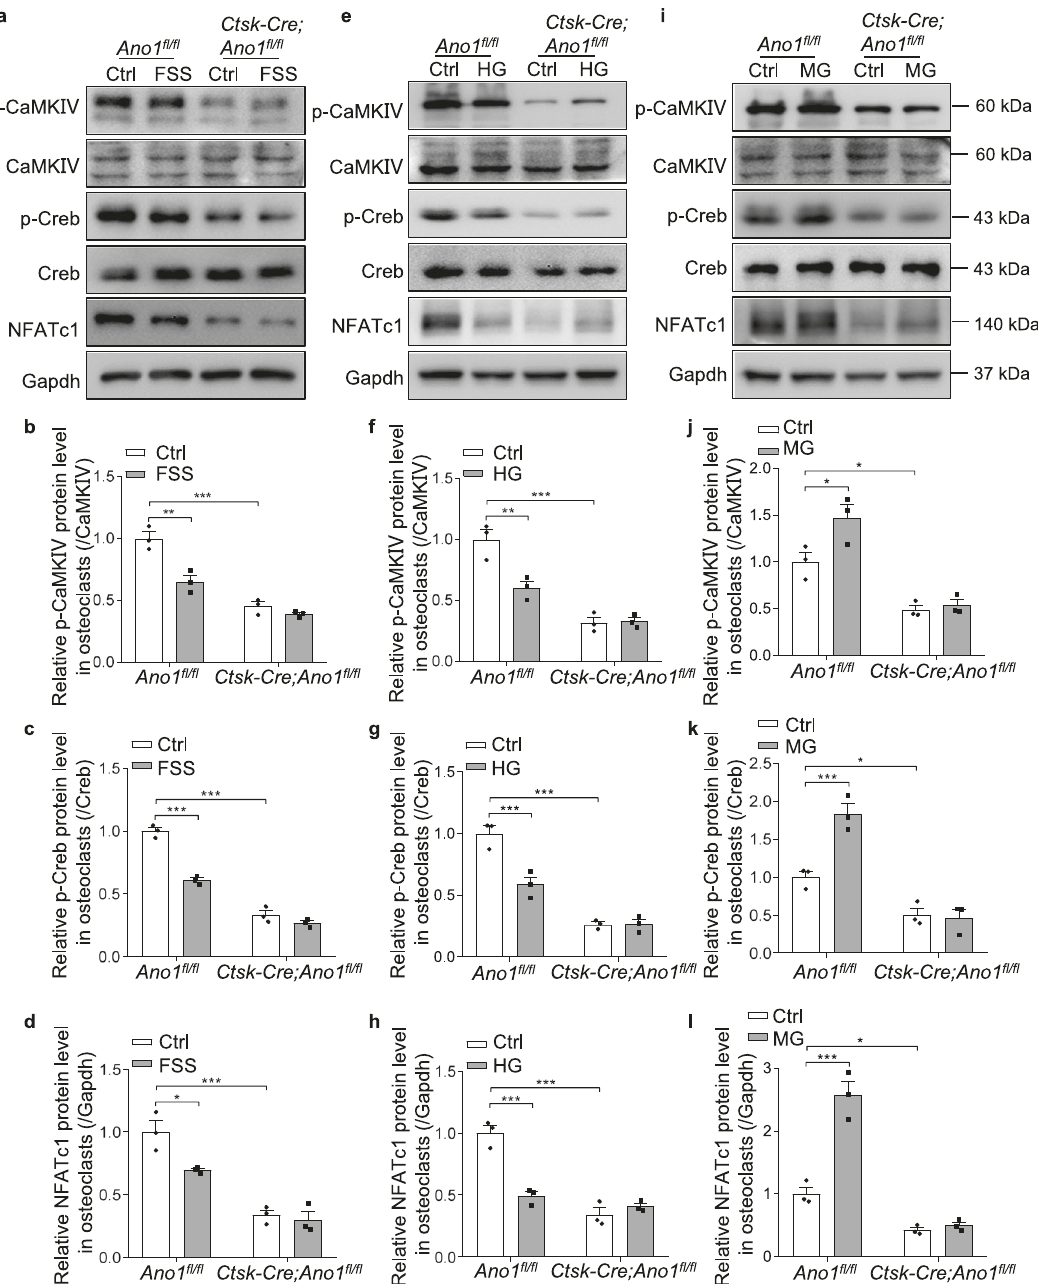
Fig. 6 Ano1 regulates calcium activated signaling in response to mechanical stimulation in osteoclast. a Western blot analysis of p-CaMKIV, CaMKIV, p-Creb,Creb and NFATc1 protein levels in Ano1 fl / fl and Ctsk-Cre;Ano1 fl / fl osteoclasts with Ctrl or FSS (12 dyn/cm 2 , 30 min/day) treatment for 2 days. b – d The quanti fi cation of p-CaMKIV, p-Creb and NFATc1 protein levels in osteoclasts. The p-CaMKIV protein level was normalized to CaMKIV, the p-Creb protein level was normalized to Creb, and the NFATc1 protein level was normalized to Gapdh. ( n = 3 independent experiments). e Western blot analysis of p-CaMKIV, CaMKIV, p-Creb,Creb and NFATc1 protein levels in Ano1 fl / fl and Ctsk-Cre;Ano1 fl / fl osteoclasts with Ctrl or HG (4 g) treatment for 2 days. f – h The quanti fi cation of p-CaMKIV, p-Creb and NFATc1 protein levels in osteoclasts. The p-CaMKIV protein level was normalized to CaMKIV, the p-Creb protein level was normalized to Creb, and the NFATc1 protein level was normalized to Gapdh. ( n = 3 independent experiments). i Western blot analysis of p-CaMKIV, CaMKIV, p-Creb,Creb and NFATc1 protein levels in Ano1 fl / fl and Ctsk-Cre;Ano1 fl / fl osteoclasts with Ctrl or MG treatment for 2 days. j – l The quanti fi cation of p-CaMKIV, p-Creb and NFATc1 protein levels in osteoclasts. The p-CaMKIV protein level was normalized to CaMKIV, the p-Creb protein level was normalized to Creb, and the NFATc1 protein level was normalized to Gapdh. ( n = 3 independent experiments). All data are the mean ± s.e.m. Statistical analysis was performed with two-way analysis of variance (ANOVA) with Š ídák post-hoc test to determine group differences. *p < 0.05, **p < 0.01, ***p < 0.001.